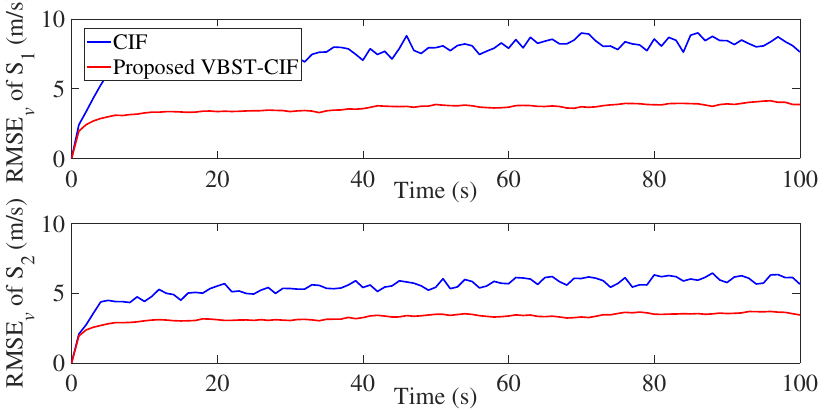
Figure 8. Velocity RMSE of different sensors in multi-sensor target tracking.